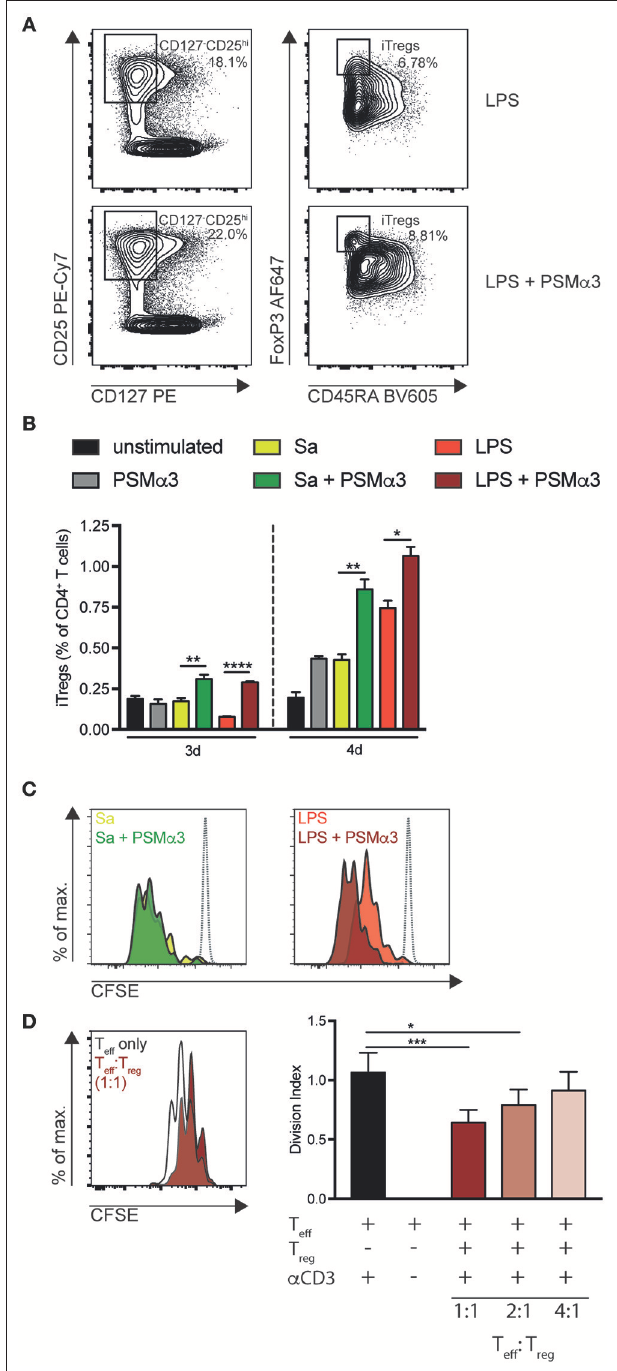
FIGURE 5 | PSM α 3-treated moDCs increase the proliferation and frequency of iT regs . (A–C) MoDCs treated for 24h with Sa lysate or LPS with or without PSM α 3 or PSM α 3 alone were co-cultured with CFSE-labeled naïve CD4 + T cells for 3 d or 4 d. iT regs were analyzed by flow cytometry and characterized as CD4 + CD127 − CD25 hi CD45RA − Foxp3 hi cells (A) . The frequency of iT regs from CD4 + T cells (B) and the proliferation of iT regs (C) co-cultured with TLRL-only or in combination with PSM α 3-treated mDCs was analyzed (n ≥ 5performedintriplicates,mean ± SEM).ProliferationwascomparedtoTcells (Continued)